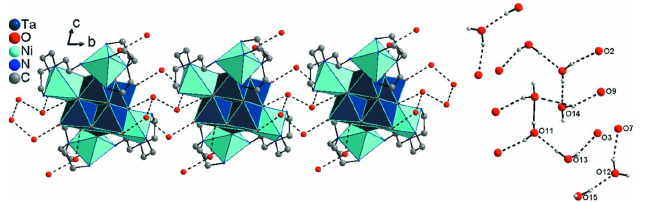
Figure 5 View of the hydrogen-bonded layer extending parallel to the bc plane by linking the [010] chains via O water (cid:2)(cid:2)(cid:2) N bonds (black dashed lines: O water (cid:2)(cid:2)(cid:2) O water ; green dashed lines: O water (cid:2)(cid:2)(cid:2) N). Hydrogen atoms were omitted for